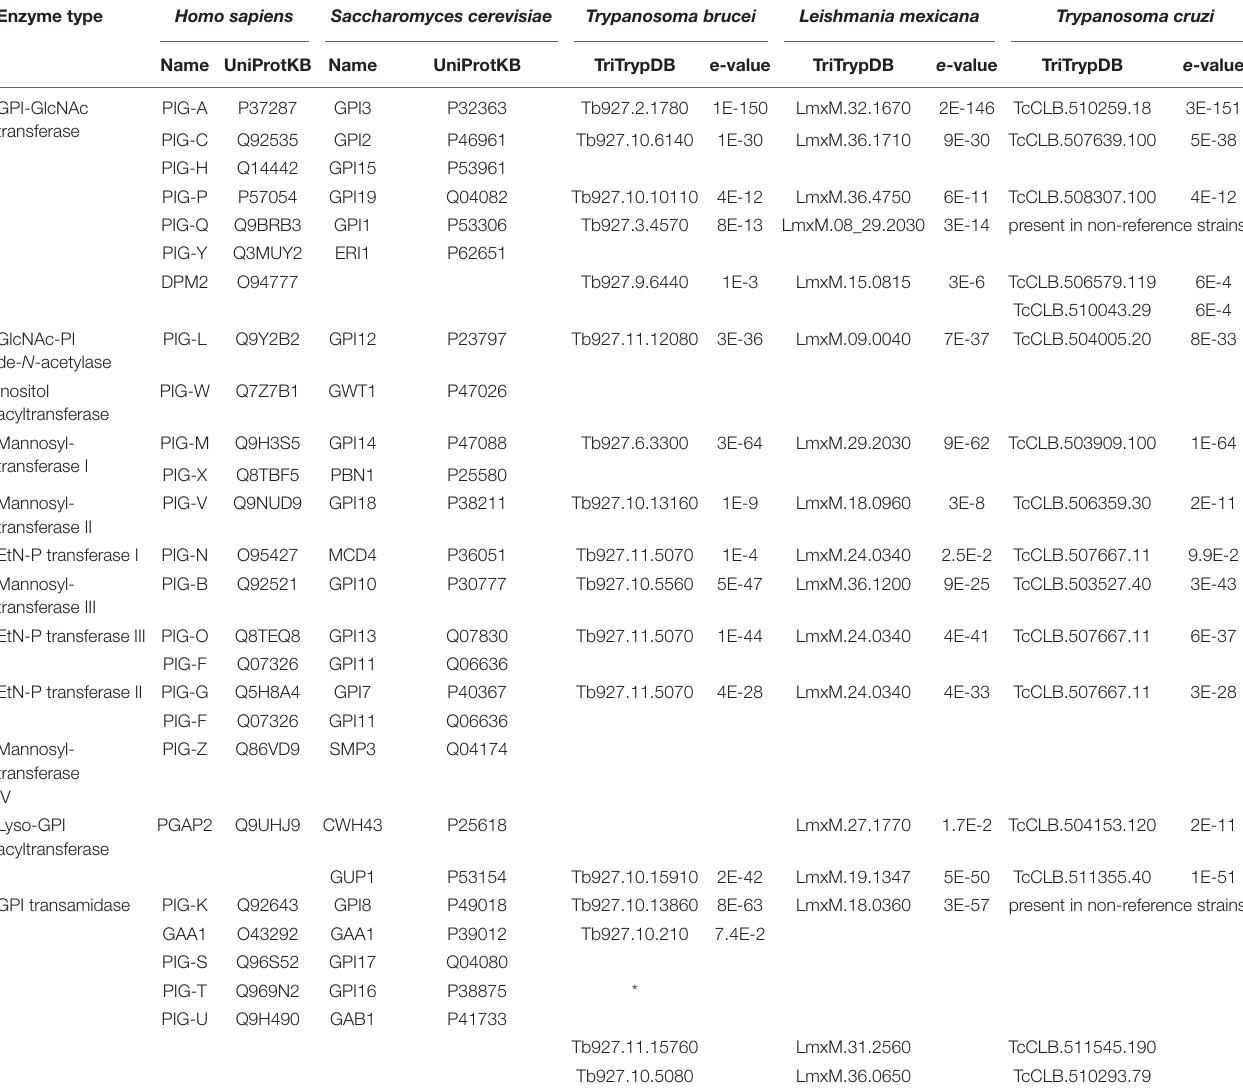
TABLE 1 | List of proteins involved in the GPI biosynthesis pathway. Enzyme